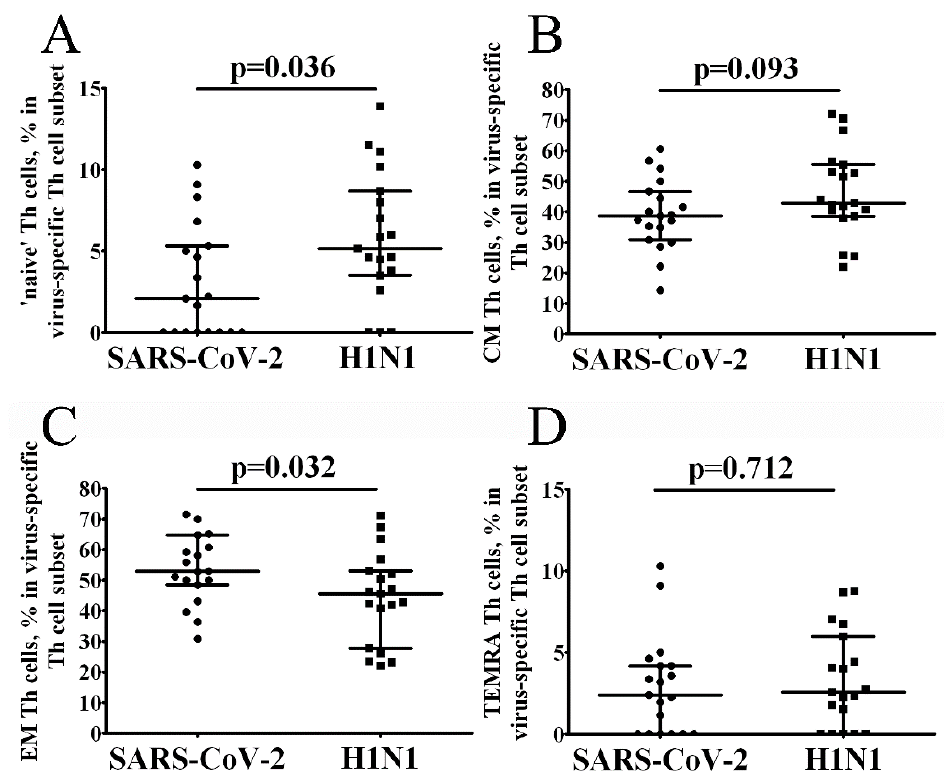
Figure 1. Distribution of ‘naïve’, central memory, effector memory and TEMRA cells among total SARS-CoV-2- and H1N1-specific CD4+ T cells. Scatter plots A-D showing the percentages of ‘naïve’ ( A ), central memory ( B ), effector memory ( C ) and TEMRA ( D ) cells among the total virus-specific Th cell population, respectively. Black circles—SARS-CoV-2-specific CD4+ T cells ( n = 19); black squares—H1N1-specific CD4+ T cells. Each dot represents individual subjects, and horizontal bars represent the group medians and quartile ranges (Med (Q25; Q75). A statistical analysis was performed with the Mann-Whitney U test.